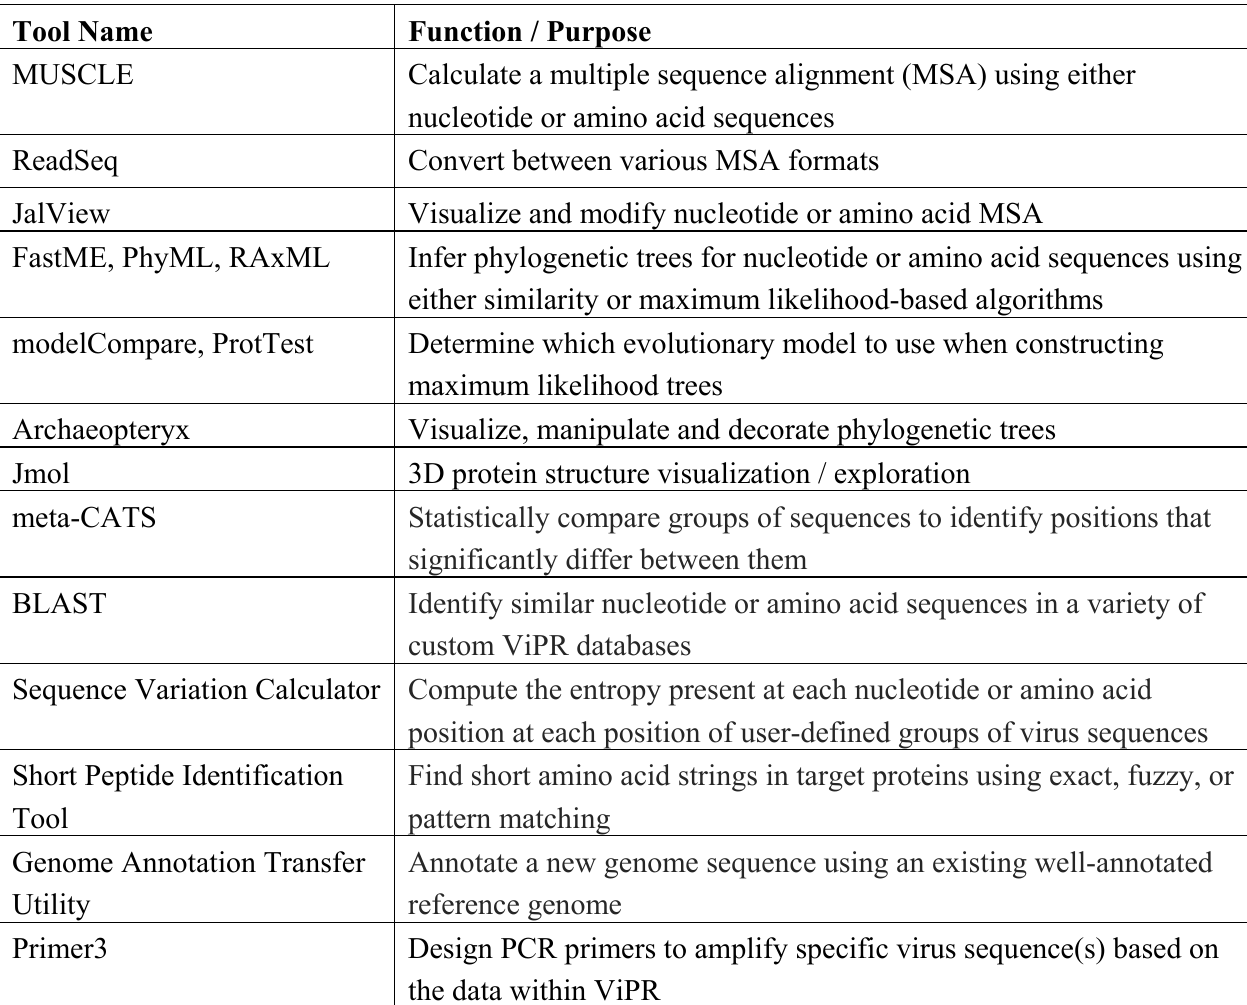
Table 2. Analytical and visualization tools integrated into